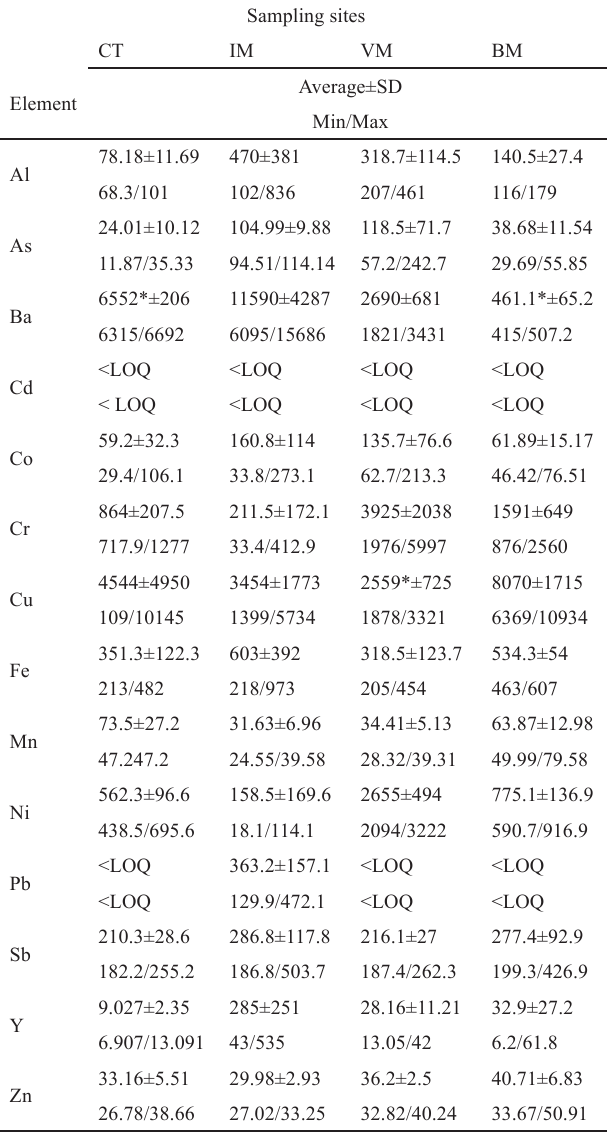
Table 2 . Mineral contents in µg/Kg and mg/Kg for 54 dehydrated bee pollen samples collected from four sites in the Iron Quadrangle, MG, Brazil. (*) average of concentration no samples with